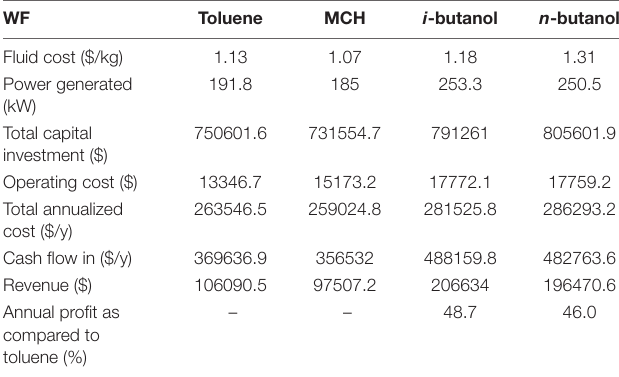
TABLE 6 | Economic comparison of toluene, methylcyclohexane, n -butanol, and i